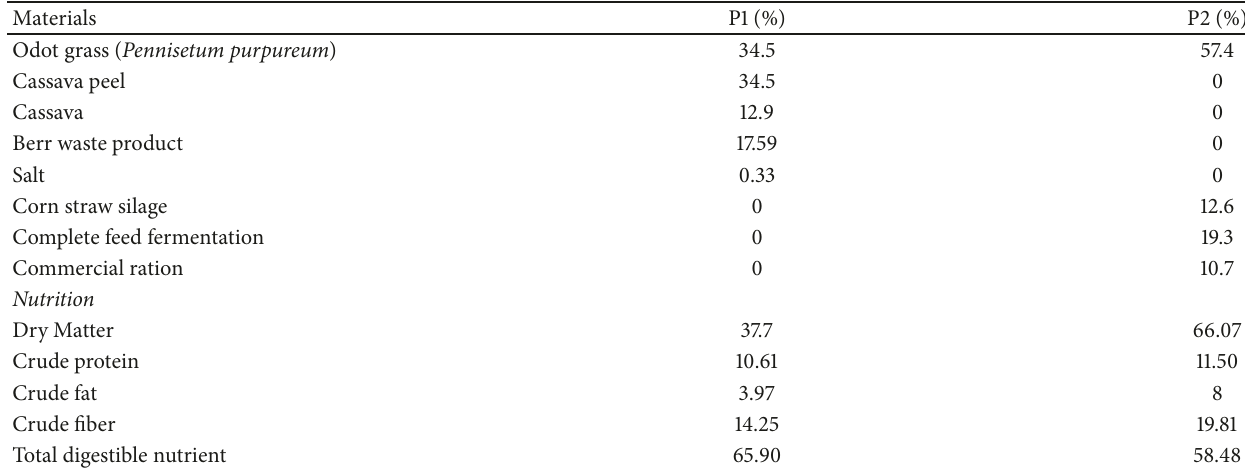
Table 1: Ingredients and chemical composition of the treatments ration.